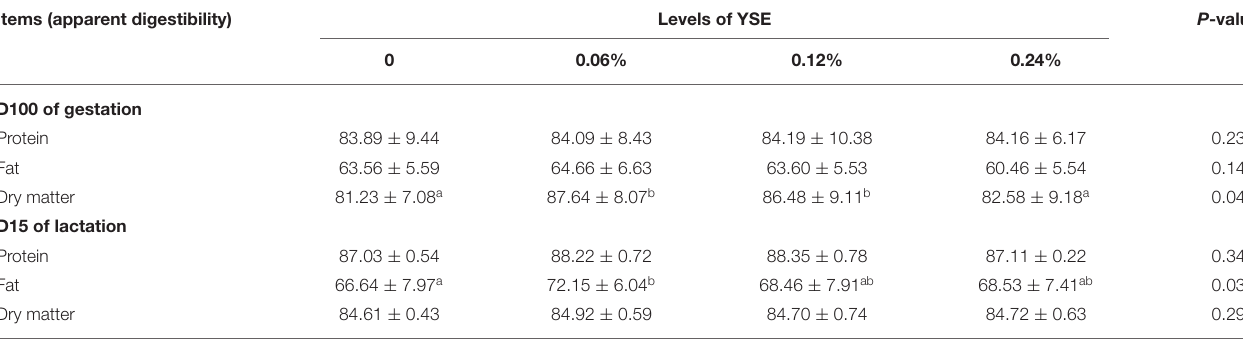
TABLE 4 | Effect of dietary YSE to nutrients apparent digestibility in gestating and lactating sow. Items (apparent digestibility)